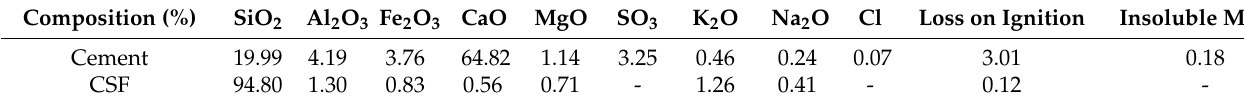
Table 2. Chemical arrangement of cement and CSF.